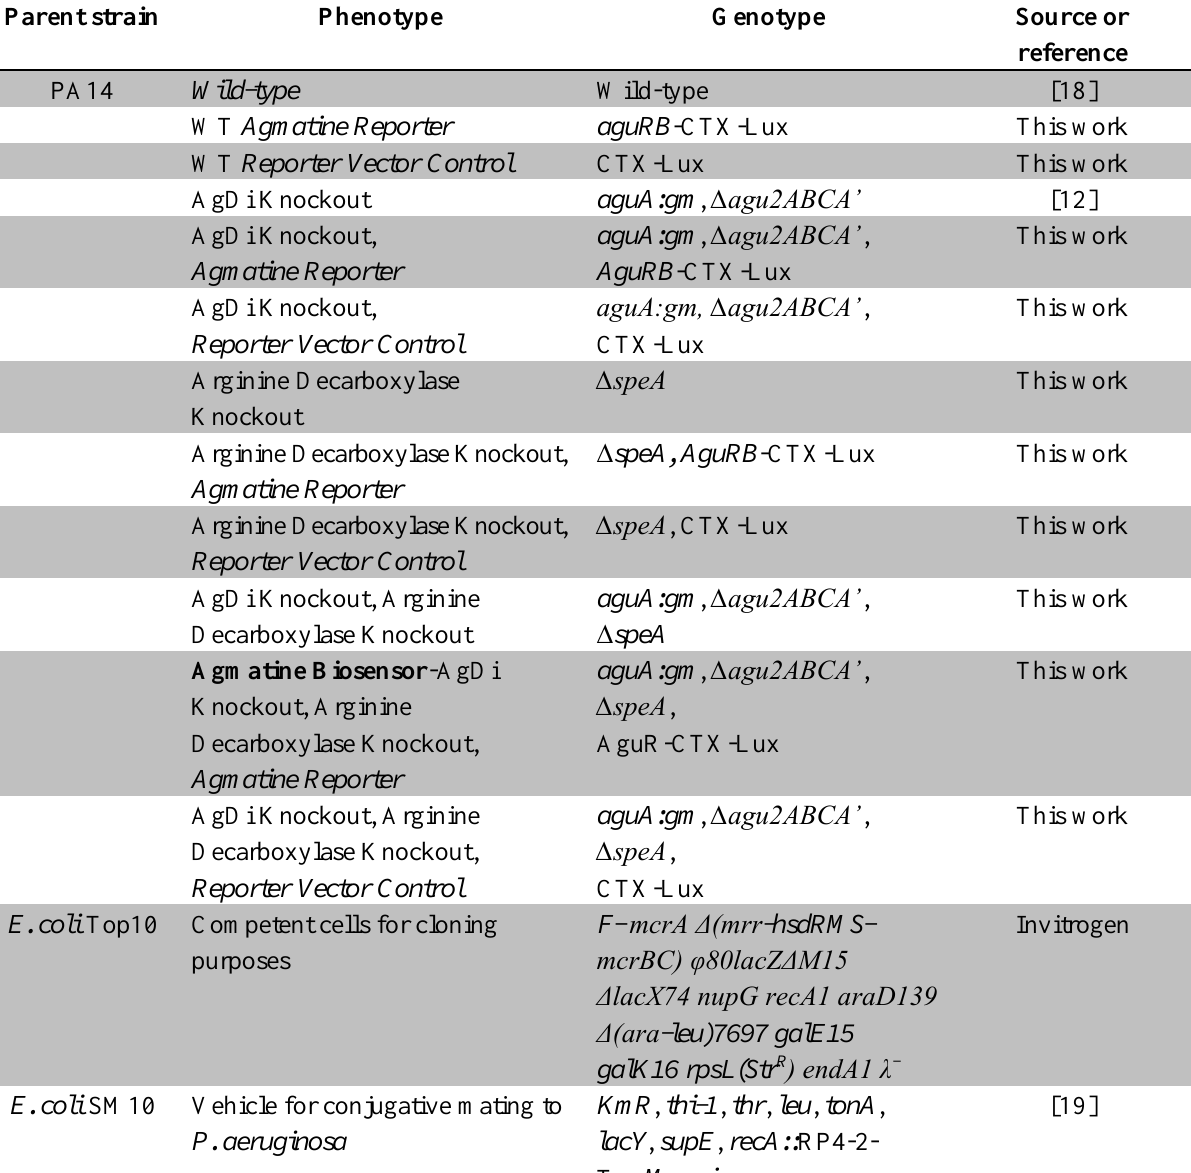
Table 1. Bacterial